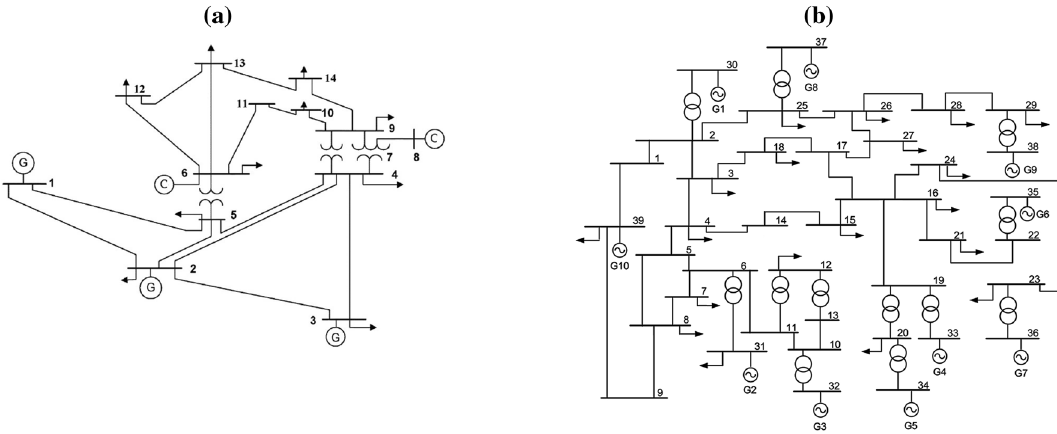
Fig. 2 Single-line diagram of a IEEE 14-bus , and b IEEE 39-bus test